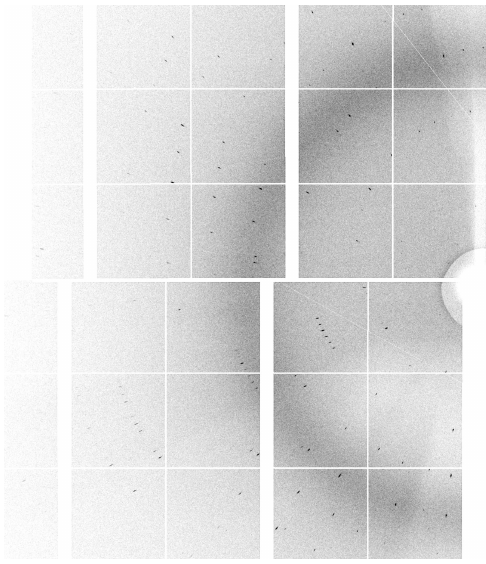
Figure 6 A fragment of a snapshot diffraction pattern from single thaumatin microcrystal recorded using the JUNGFRAU 16M detector and a large- BW X-ray pulse ( (cid:2) (cid:2) / (cid:2) = 2.2% FWHM) from SwissFEL.